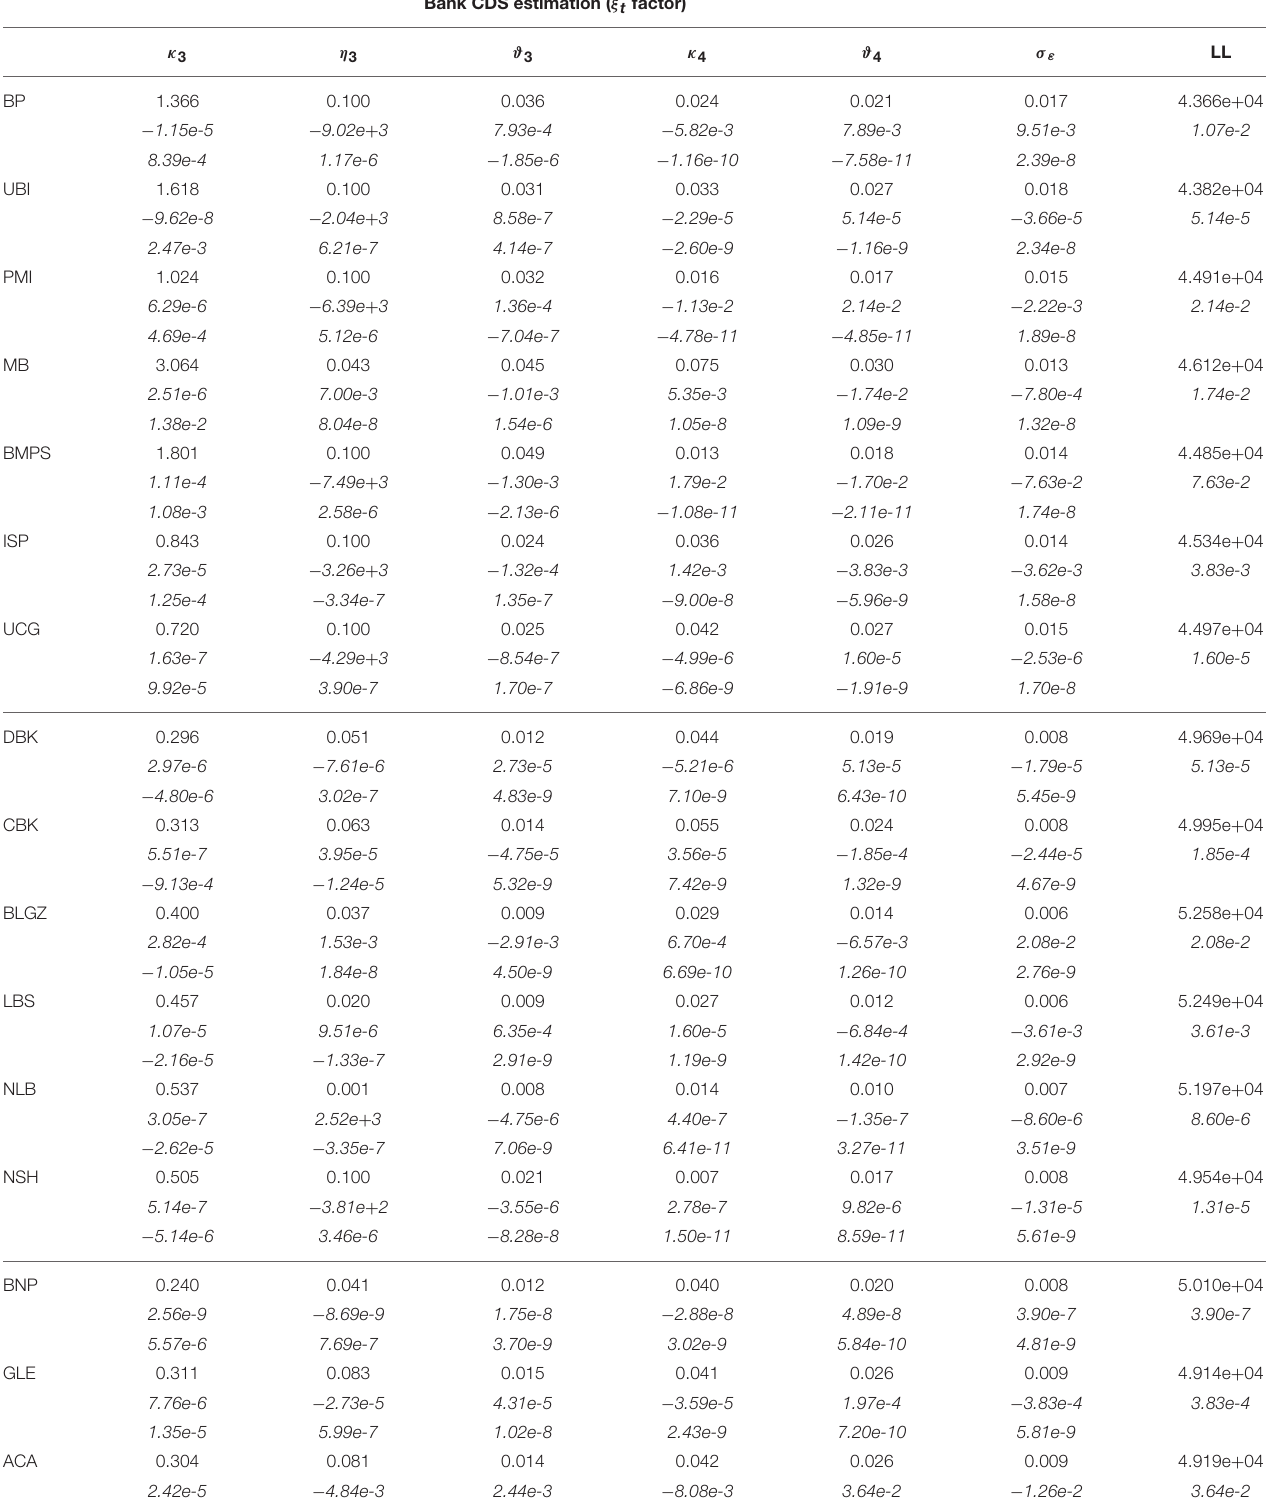
TABLE 8 | Estimated parameters of the multi-factor Vasicek